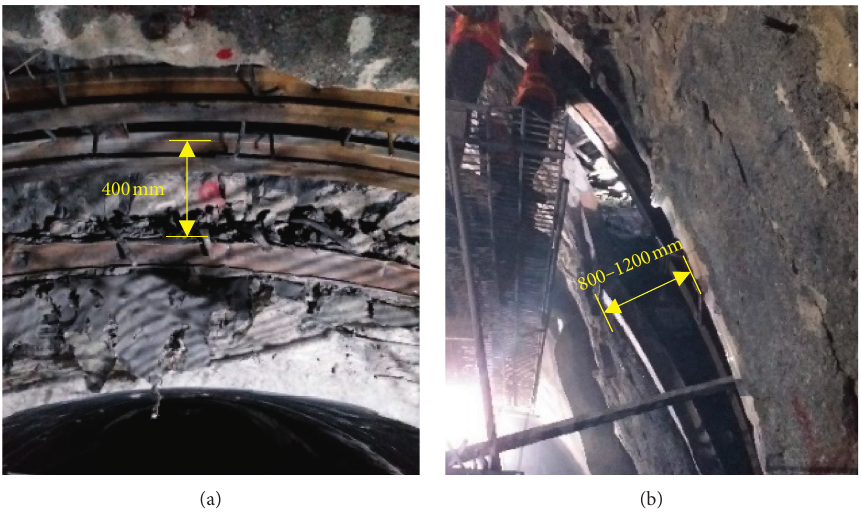
Figure 2: Large deformations of surrounding rocks.